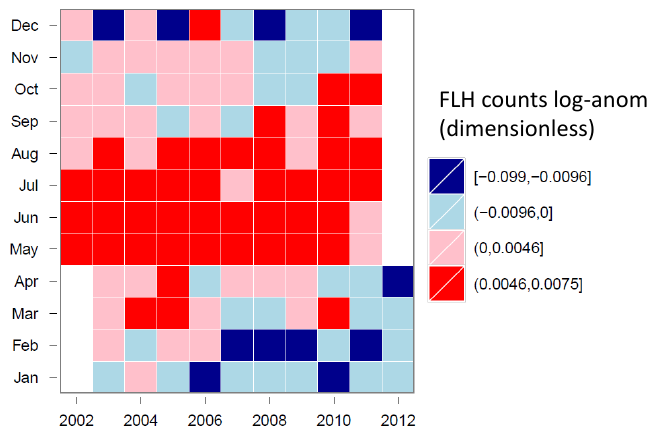
Figure 12. Tile-plot of FLH counts for the VDG cluster (log-anomalies).